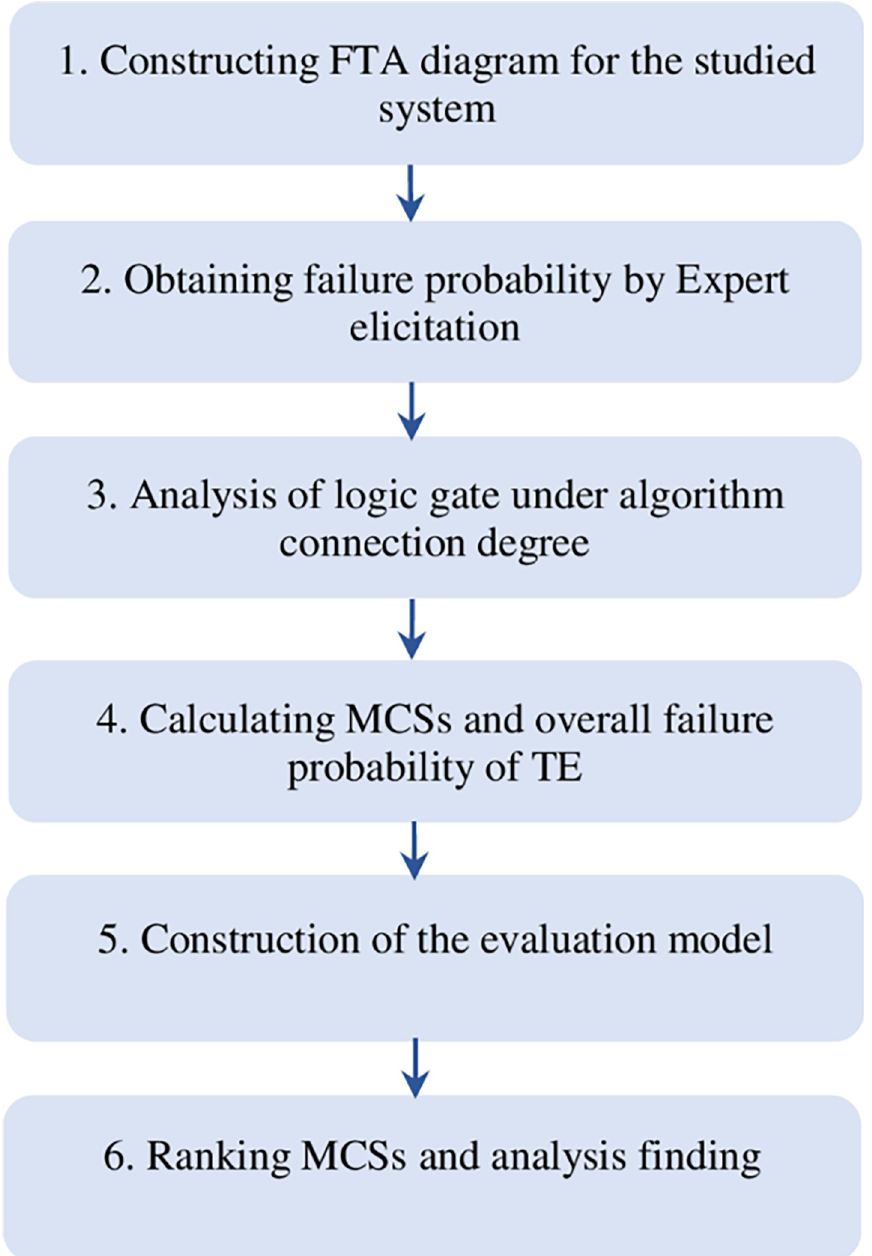
Fig 1. Evaluation flowchart based on the model of